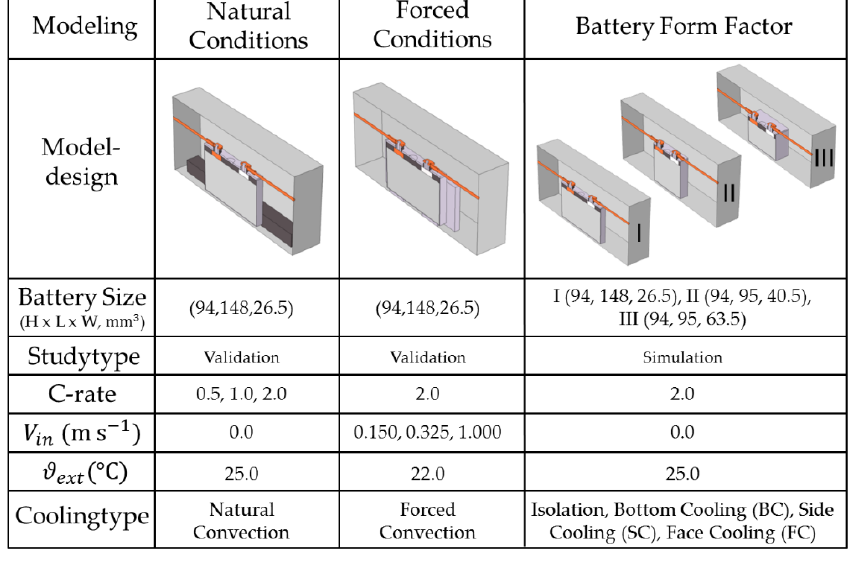
Figure 5. Model study design variants shown with respect to the underlying degrees of freedom.